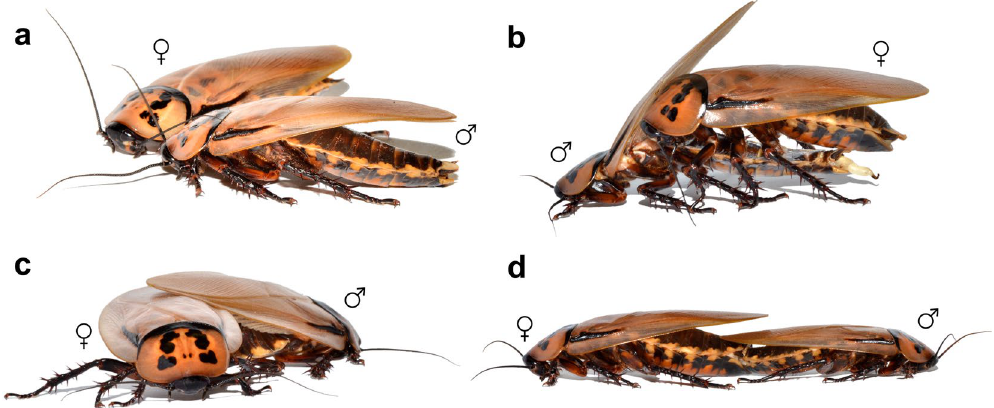
Figure 1. Ritualized courtship sequence as performed by E. distanti : ( a ) The male positions himself in front of the female, pumps his abdomen and raises his wings, ( b ) the female climbs on the male’s back where she is halted by his wings. The male then grasps the female genitalia by genital hook positioned on his right phallomere, ( c ) after genital connection is achieved, the male moves forward and the female performs a clockwise rotation 180 degrees off his back. Note the male wings pushing against the female body; ( d ) couple is then fixed in end-to-end